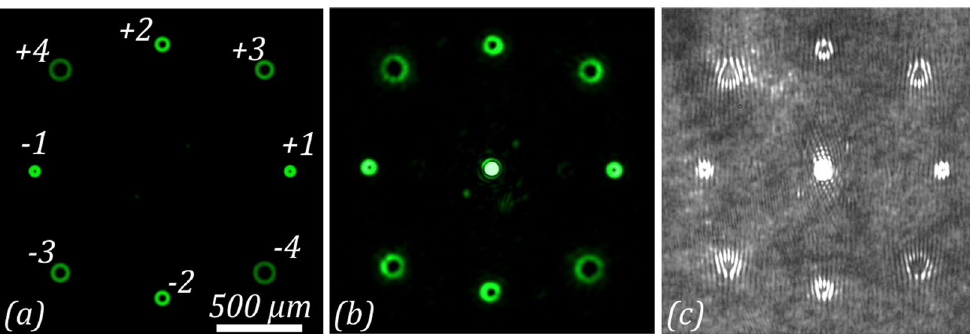
Figure 6. Diffraction pattern formed in the far-field region when passing the laser beam through the amplitude diffractive optical element, generating a superposition of eight vortex beams. ( a ) Simulation and ( b ) experimental result. ( c ) Experimentally obtained interference patterns of the generated vortex